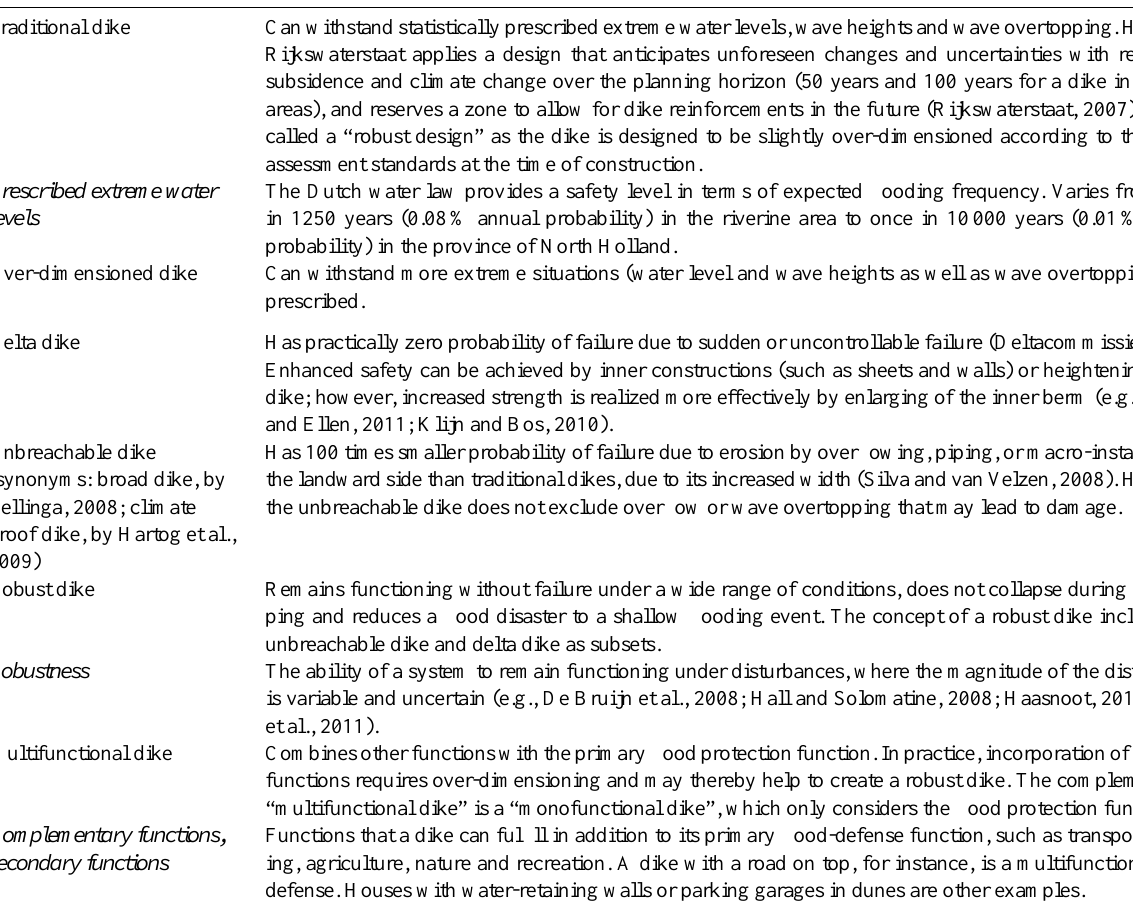
Table 1. Explanation of dike concepts and related terminology in the Netherlands; the relation between the various concepts is shown in Fig.